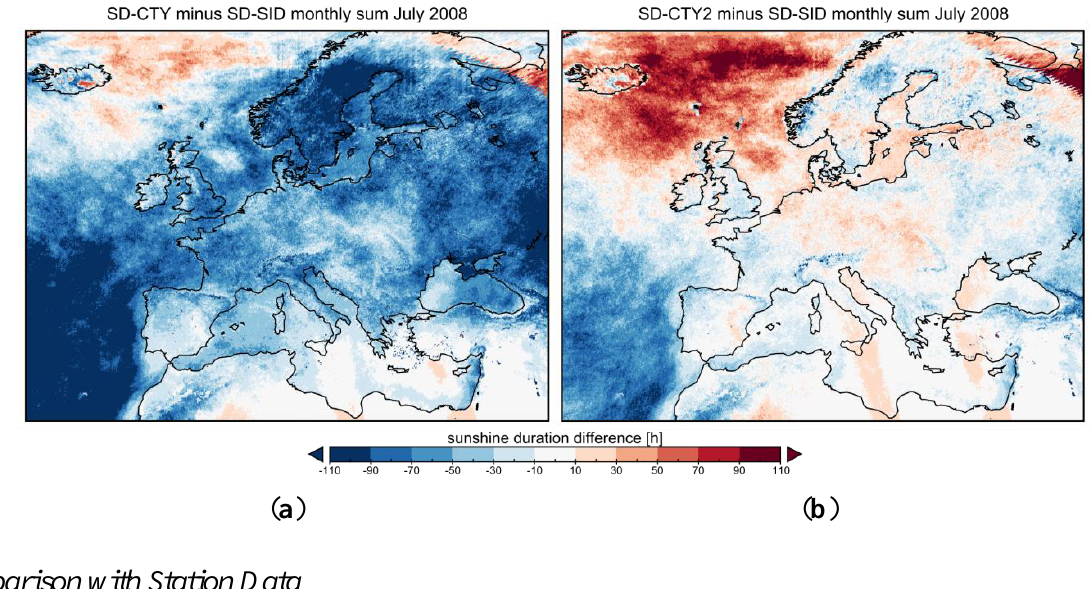
Figure 14. Difference of SD-CTY minus SD-SID ( a ), and SD-CTY2 minus SD-SID ( b ) for monthly sums of July 2008. In the retrieval of SD-CTY2 a factor of 0.935 was applied for fractional